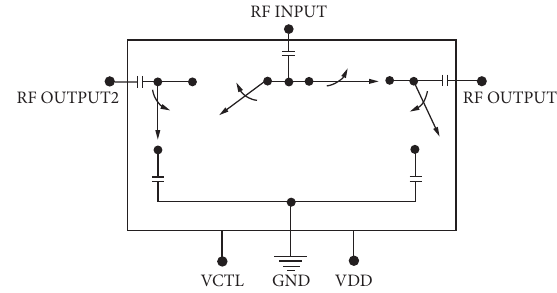
Figure 11: SPDT switch block diagram.